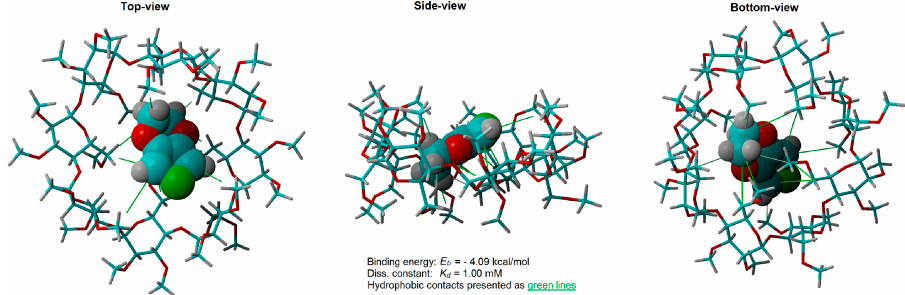
Figure 2. Molecular docking model of the host-guest EDOT ∙ TMe- γ CD complex formation; hydrophobic contacts illustrated as solid green lines.